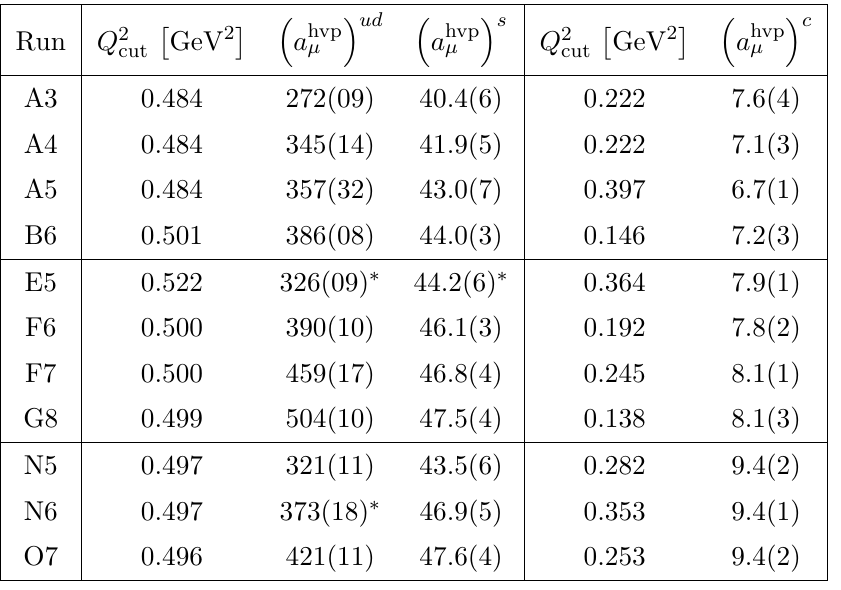
Table 3 . Results for the hadronic vacuum polarization contributions to the muon anomalous magnetic moment (in units of 10 (cid:0) 10 ) from the light, strange and charm (cid:13)avours, determined via the hybrid method, where the low-momentum representation of the VPF was determined from a (cid:12)t. Results marked by an asterisk are associated with unacceptably large values of (cid:31) 2 = dof (see text).